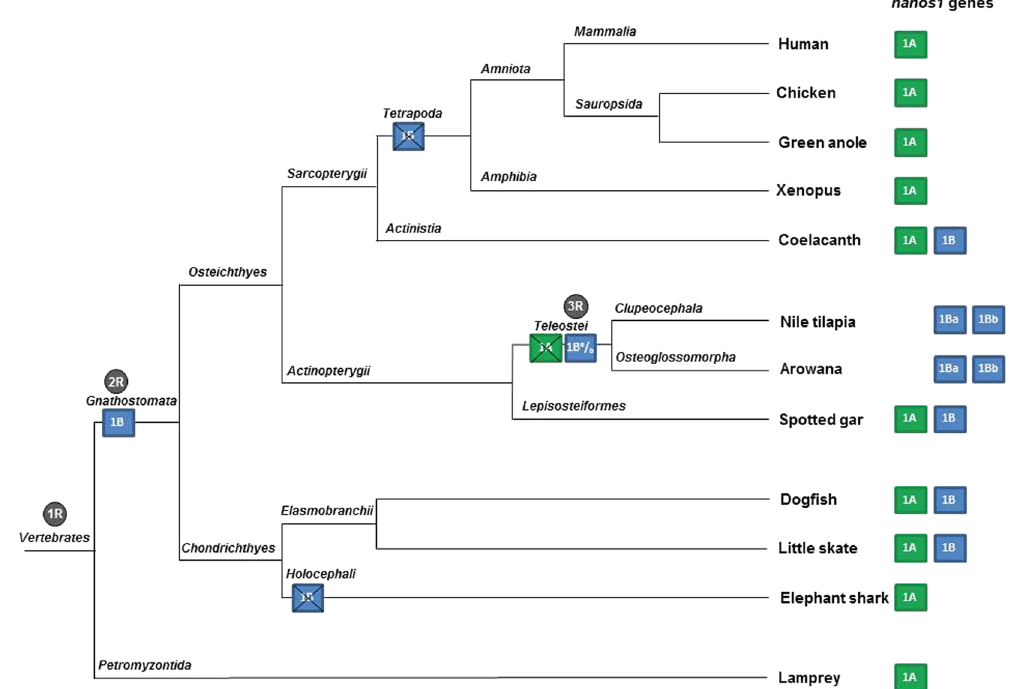
Figure 2. Hypothetical model of nanos1 gene duplications and copy losses during Vertebrate evolution. Based on nanos1 syntenies and phylogenetic trees, two rounds of duplication of the ancestral lamprey nanos1 gene were observed. At the basis of Vertebrates, the sea lamprey displays only the ancestral nanos1A gene copy. The first gene duplication giving rise to the nanos1B paralog may have occurred following the second genome duplication (2R) at the basis of Gnathostomata (box 1B). Chondrichthyan species (shark and ray) have kept both gene copies except the Holocephali (chimaera). In Osteichthyes, both paralogs were found in basal Sarcopterygii (coelacanth) but nanos1B was lost by Tetrapoda (crossed box 1B). Both nanos1A and nanos1B paralogs were found in basal Actinopterygii (spotted gar) but nanos1A was lost in Teleostei (crossed box 1A). Coinciding with the third round of whole genome duplication (3R), nanos1B gene copy would have undergone a second duplication in a Telelost ancestor giving rise to nanos1Ba and nanos1Bb gene copies (box 1B a / b ). The nanos1 paralogs present in the different species are summarized on the